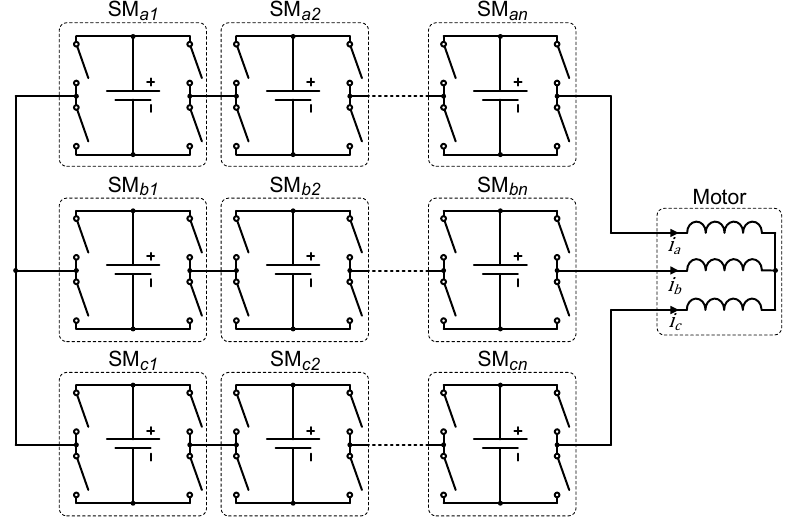
Figure 1. Cascaded H-bridge circuit consisting of three phases with scalable number of sub modules.